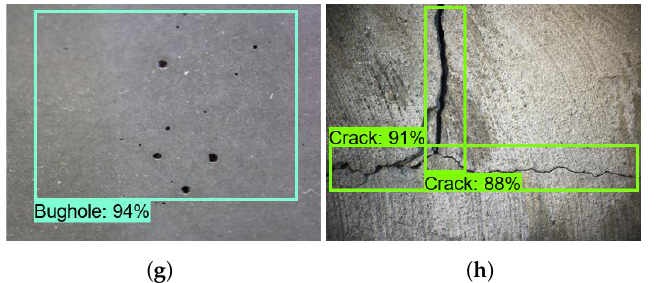
Figure 15. Inception-ResNet-v2 defect detection results. ( a ) Crack; ( b ) Honeycomb defect; ( c ) Tree root intrusion; ( d ) Plant intrusion; ( e ) Deposit; ( f ) Pothole; ( g ) Bughole; ( h )